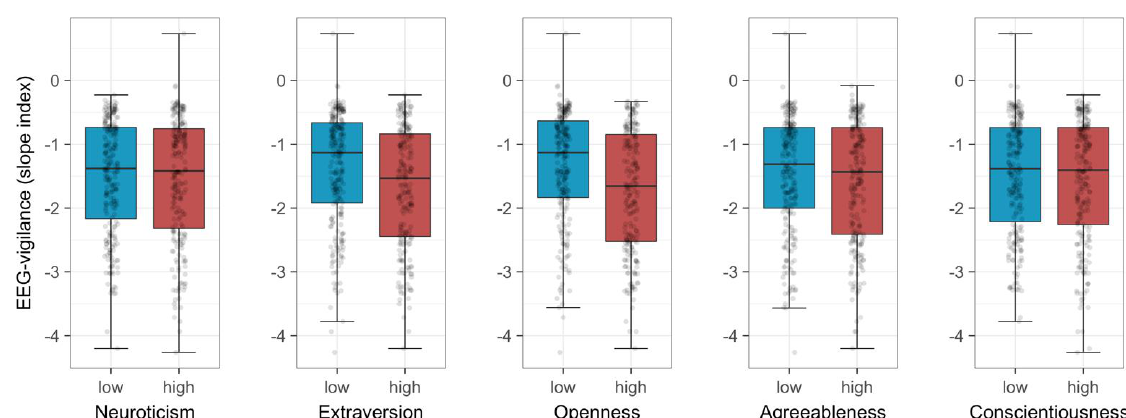
Figure 2. Boxplots showing the differences in EEG-vigilance (as indicated by variable ‘slope index’) as a function of Big Five personality trait. Boxplots are stratified by groups scoring low vs. high on the respective Big Five scale (i.e., participants with scores in the lower vs. upperhalfoftheascendingdistributionarecompared). Boxesrepresenttheinterquartilerange(databetweenthelowerandupperquartile), with the horizontal line corresponding to the median. Whiskers extend to the furthest observation within 1.5 times the interquartile range from the lower and upper quartile. Dots represent single observations, jittered horizontally to avoid overplotting. Statistical analyses revealed significant associations between EEG-vigilance variable ‘slope index’ and both extraversion and openness to